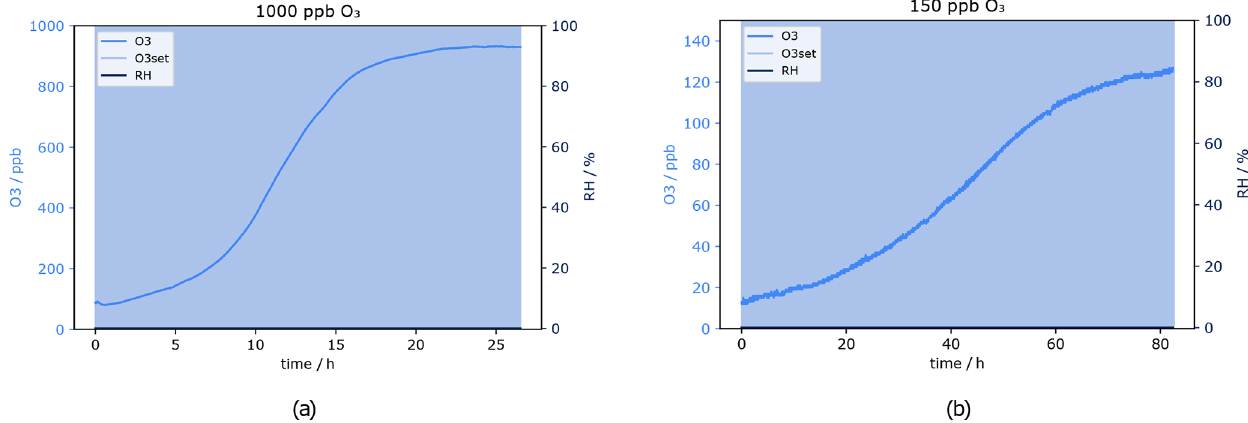
Figure 12. O 3 mixing ratio after Na 2 S 2 O 3 scrubber at 0% RH. Flows and O 3 levels before scrubber: (a) 550sccm, 1000ppb and (b) 620sccm, 150ppb.